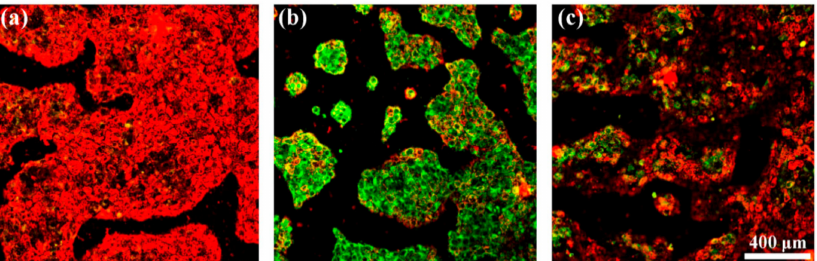
Figure 9. Confocal images with JC-1 assay of HEK-a cells incubated with ( a ) free culture medium as a control group, ( b ) PBS, and ( c ) 20 µ g / mL C 60 -PDA-GSH nanoparticles for 3 h and then treated with 1 mM H 2 O 2 for 1 h